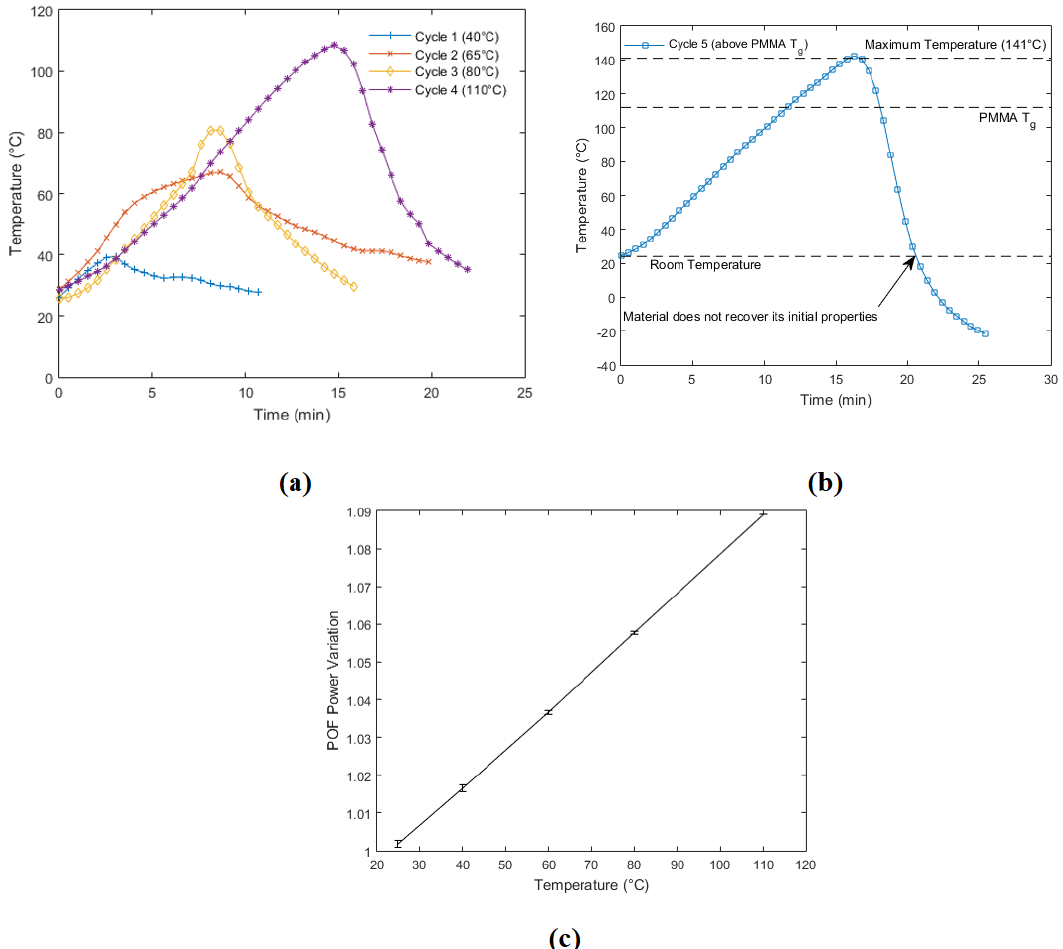
Figure 6. Repeatability tests for the POF temperature sensor. ( a ) Cycles ranging from 40 to 110 °C to show the sensor behavior with increasing and decreasing temperatures. ( b ) Sensor response on a test with temperatures higher than the PMMA T g . ( c ) Repeatability of the temperature sensor on the cycles presented in ( a ).